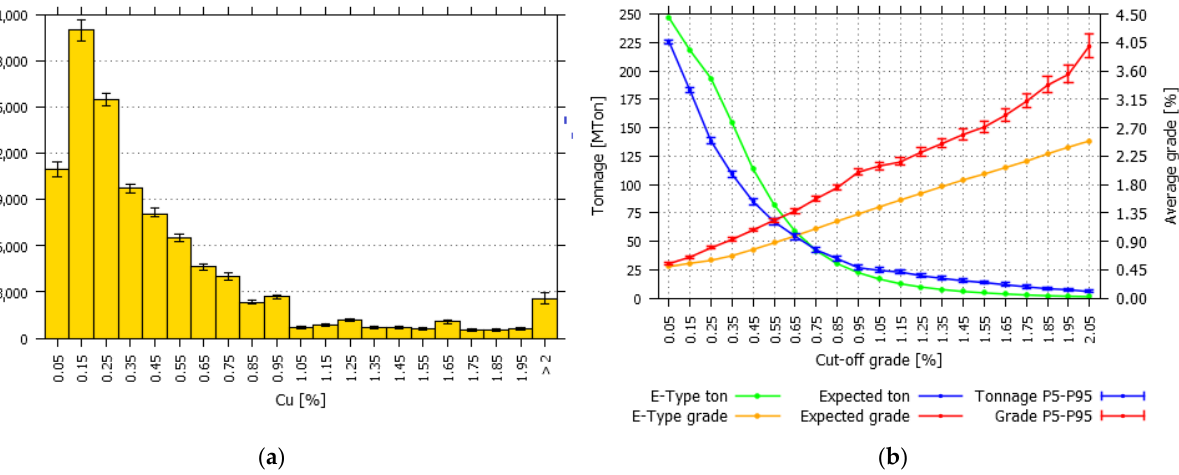
Figure 5. Summary of BMT block model: ( a ) Histogram of copper grades; ( b ) Grade-tonnage curves for the set of simulated realizations and E-Type model. Both graphs include error bars with 5th and 95th percentile per interval.